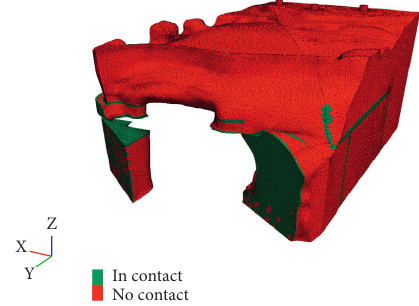
Figure 11: Contact of cracks in the partial model of Yuanjue Cave.